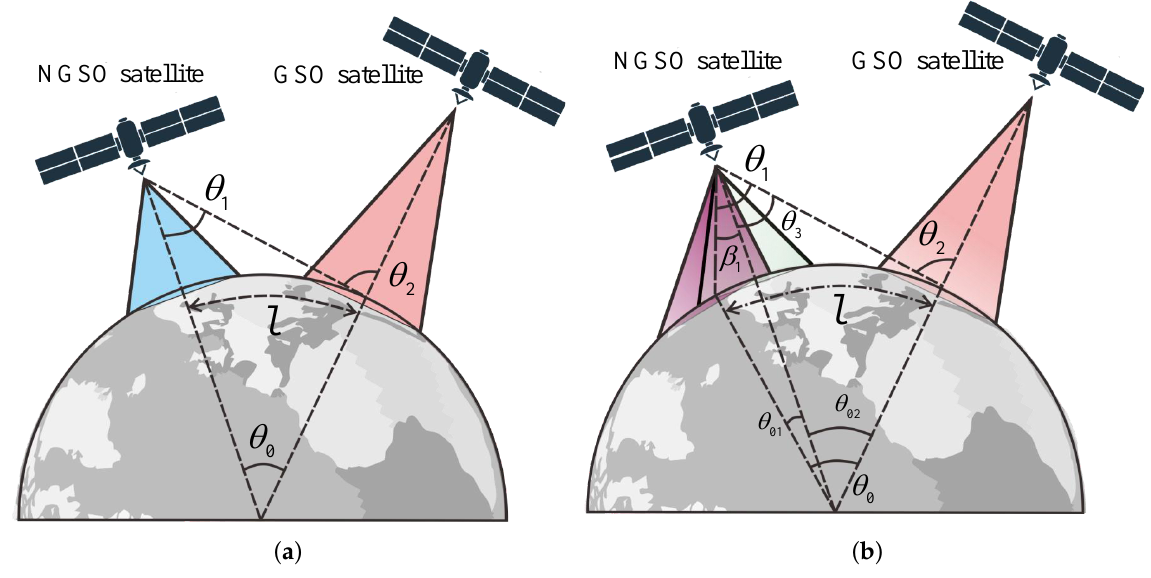
Figure 4. The downlink scenarios where beams have no tilting angle and only NGSO satellite beam have a tilting angle. ( a ) Pointing of NGSO and GSO satellites beams without tilting angle; ( b ) Pointing of NGSO satellite beams with tilting angle β 1